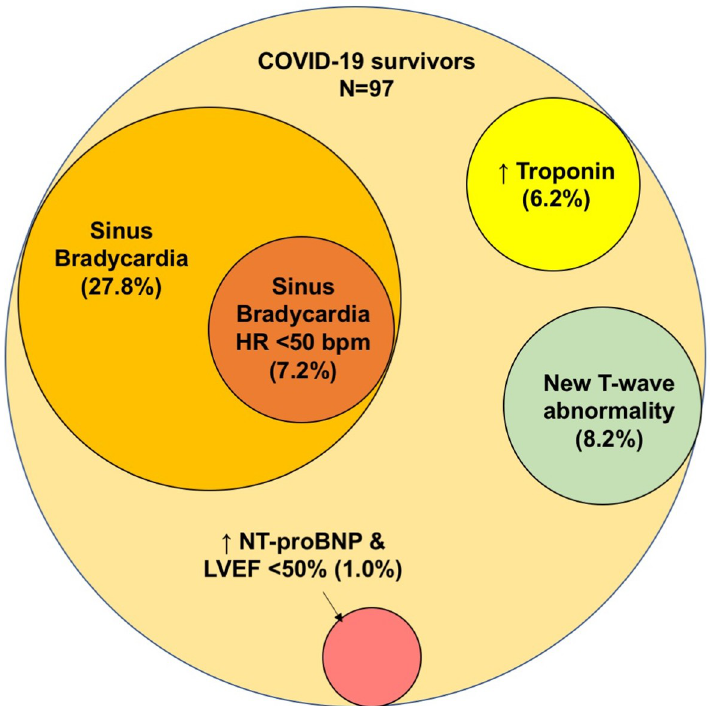
Fig 2. Latent cardiac abnormalities amongst 97 COVID-19 survivors 2–4 weeks after discharge for the index hospitalization for COVID-19.